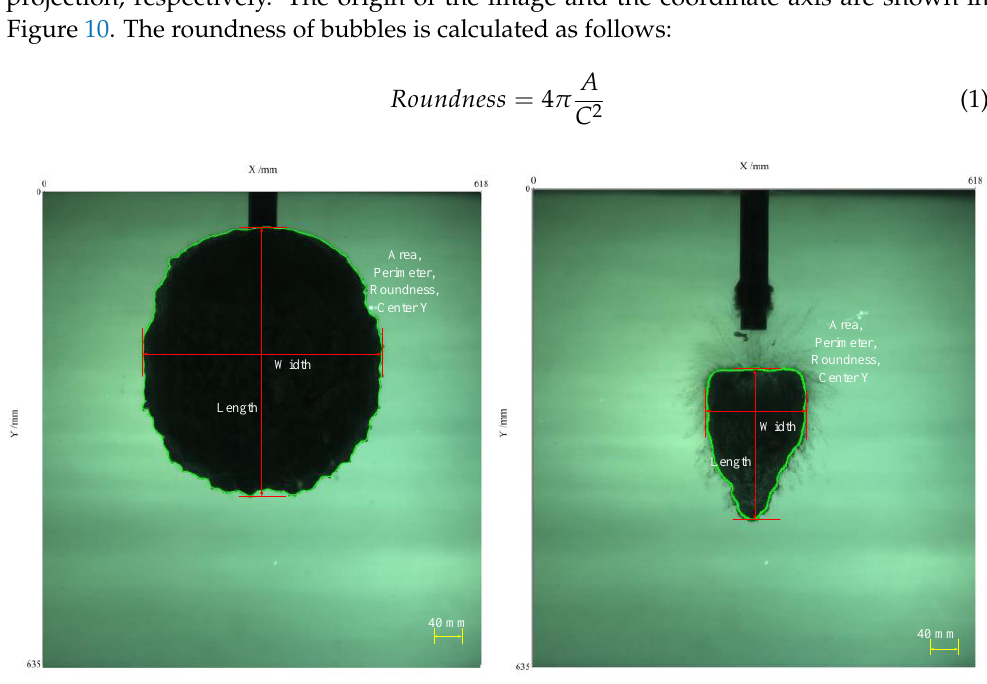
Figure 10. The roundness of bubbles is calculated as follows: